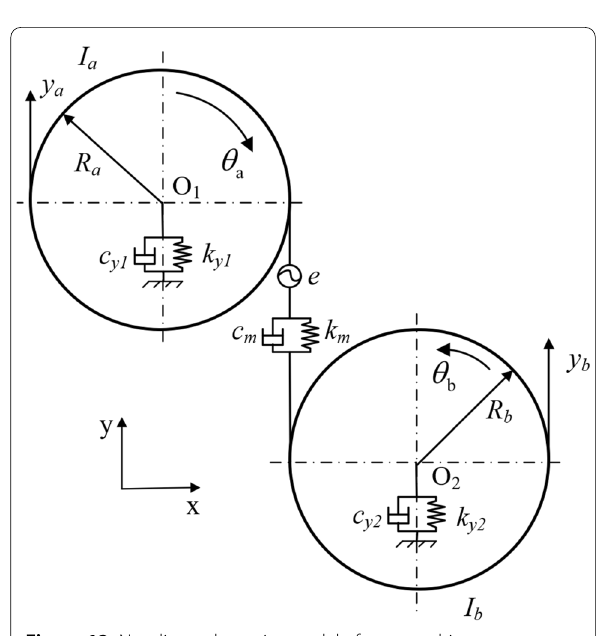
Figure 12 Non-linear dynamics model of gear